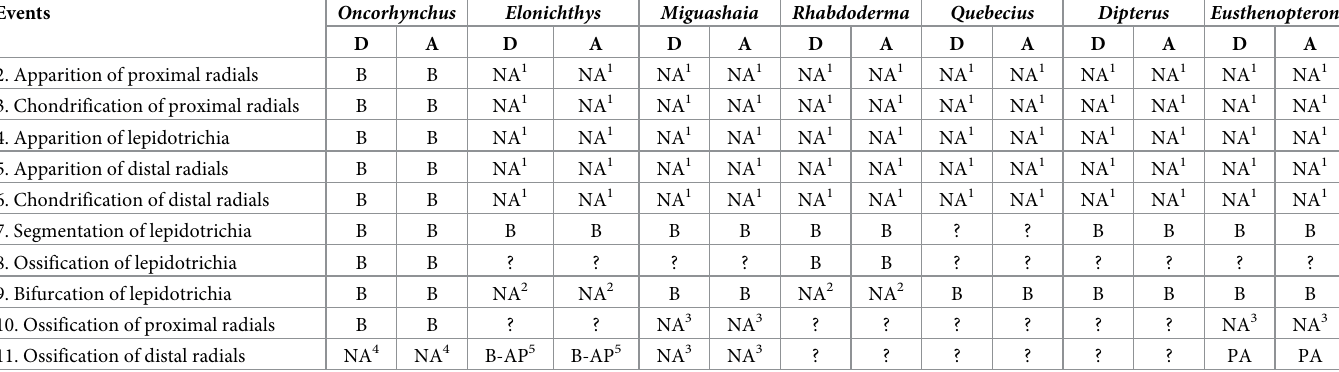
Table 3. Directions of developmental sequences of ten out of eleven events for the dorsal (D) and anal (A) fins in living and extinct osteichthyans. See Nomenclature for the complete list of events. Events